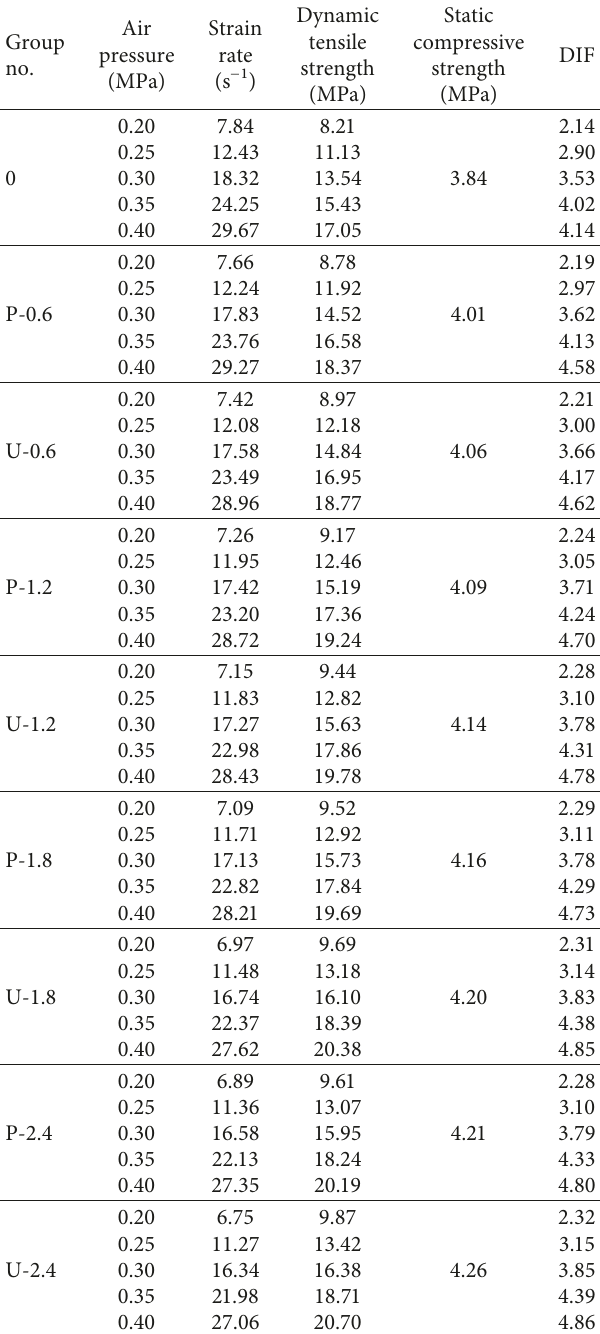
Table 8: Results of fitting parameters of each group of fiber concrete using the proposed equation. Group